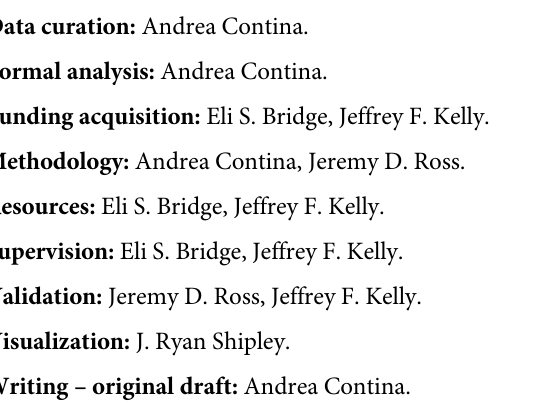
genotypes for each bird are reported in the right columns. The lower panel shows spring migration arrival dates, body mass, and wing chord for each individual sampled in Louisiana (Johnson Bayou). Clock and Adcyap1 microsatellite genotypes for each bird are reported in the right columns. S2 Table. Microsatellite allele size variation at Clock and Adcyap1 across Painted Bunting populations. Values are reported for each allele (allele-A and allele-B) and for the average of the two alleles. Allele-A indicates short alleles and allele-B indicates long alleles. S3 Table. Observed (Ho) and expected (He) heterozygosity at Clock and Adcyap1 . Signifi- cant p values (p < 0.05) indicating deviation from Hardy-Weinberg equilibrium (HWE) are marked with asterisks. S4 Table. Linkage Disequilibrium (LD) results for microsatellite at Clock (locus 1) and Adcyap1 (locus 2). There is no indication that these two loci are in LD (p >